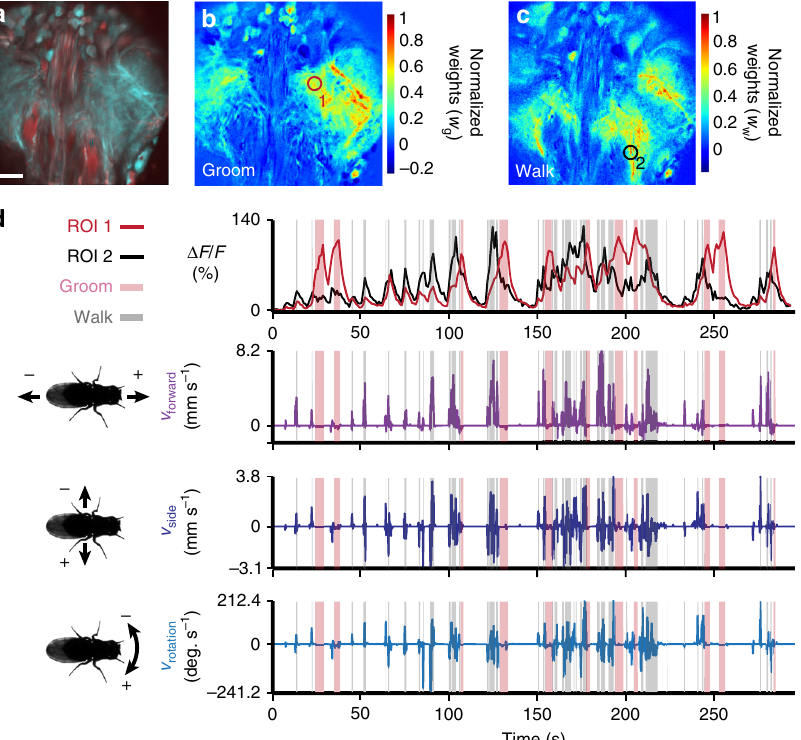
Fig. 2 Recording populations of neurons in the VNC during behavior. a Standard deviation time projection for an experiment performing horizontal section imaging of the VNC. Scale bar is 35 µ m. b , c Heat maps of linear regression weights w g and w w showing the pixel-wise relationships between fl uorescence traces and b grooming or c walking, respectively. Weights are normalized to the maximum for each image. Data are from the experiment shown in panel a . d ROI-associated fl uorescence traces (red from panel b , black from panel c ) (top). Shaded regions indicate semi-automatically detected bouts of grooming (pink) or walking (gray). Corresponding forward, sideways, and rotational velocities of the fl y (bottom)